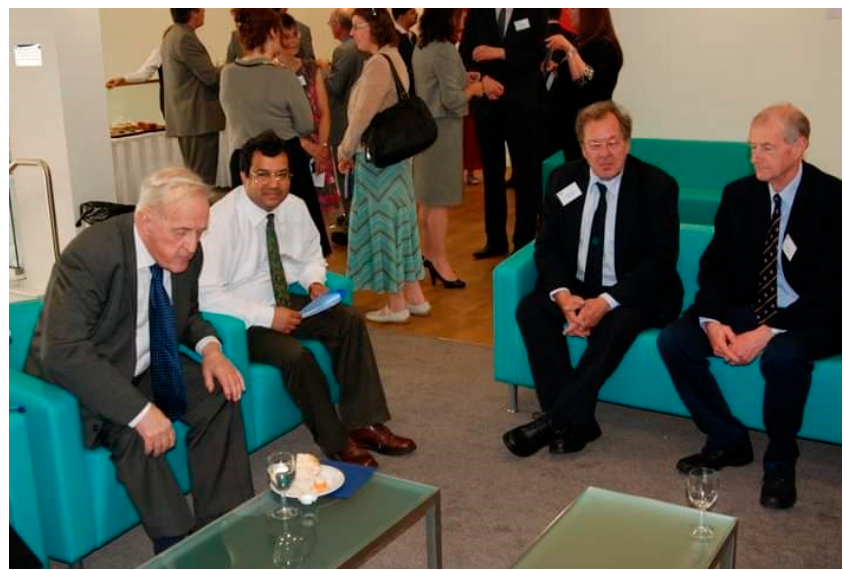
Figure 4. Bob attending the opening ceremony of the Centre for Infection, Immunity and Disease Mechanisms at the Brunel University London in 2009. From the left: Sir David Weatherall, Uday Kishore, Bob, and Prof Ken Reid.